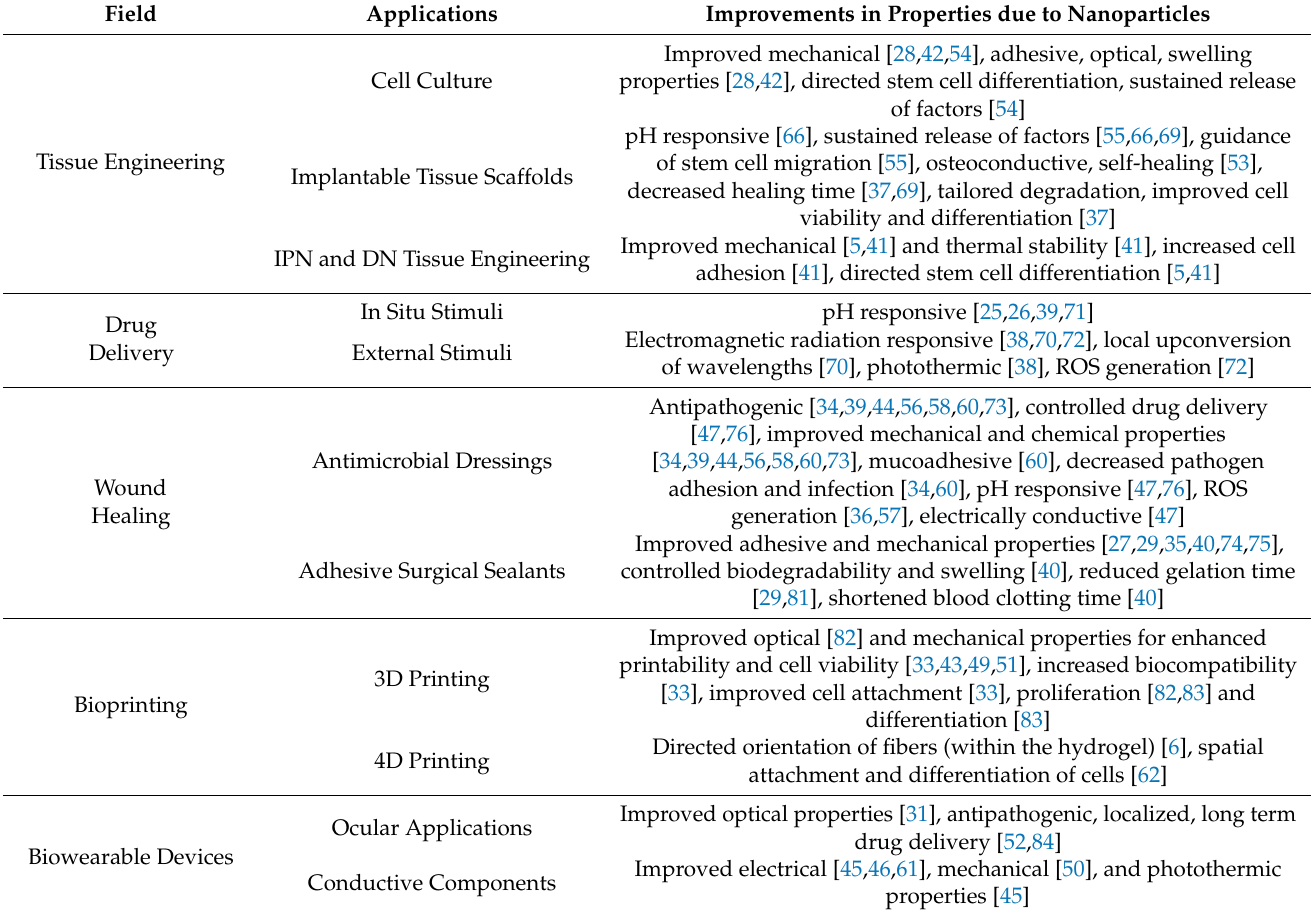
Table 3. Summary of hydrogel nanocomposite applications and nanoparticle-mediated hydrogel improvements.